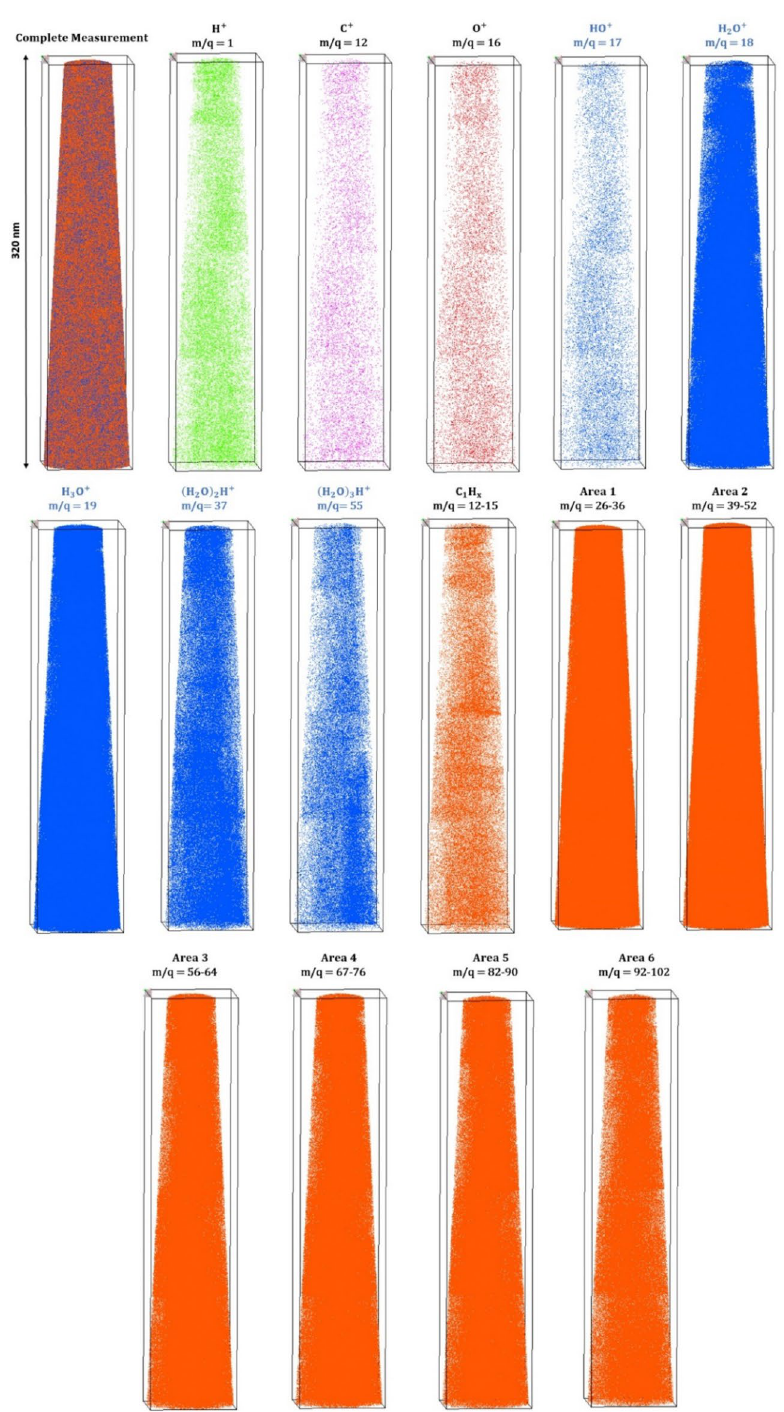
Figure 5. Individual maps of the reconstructed volume for different elements and molecules are